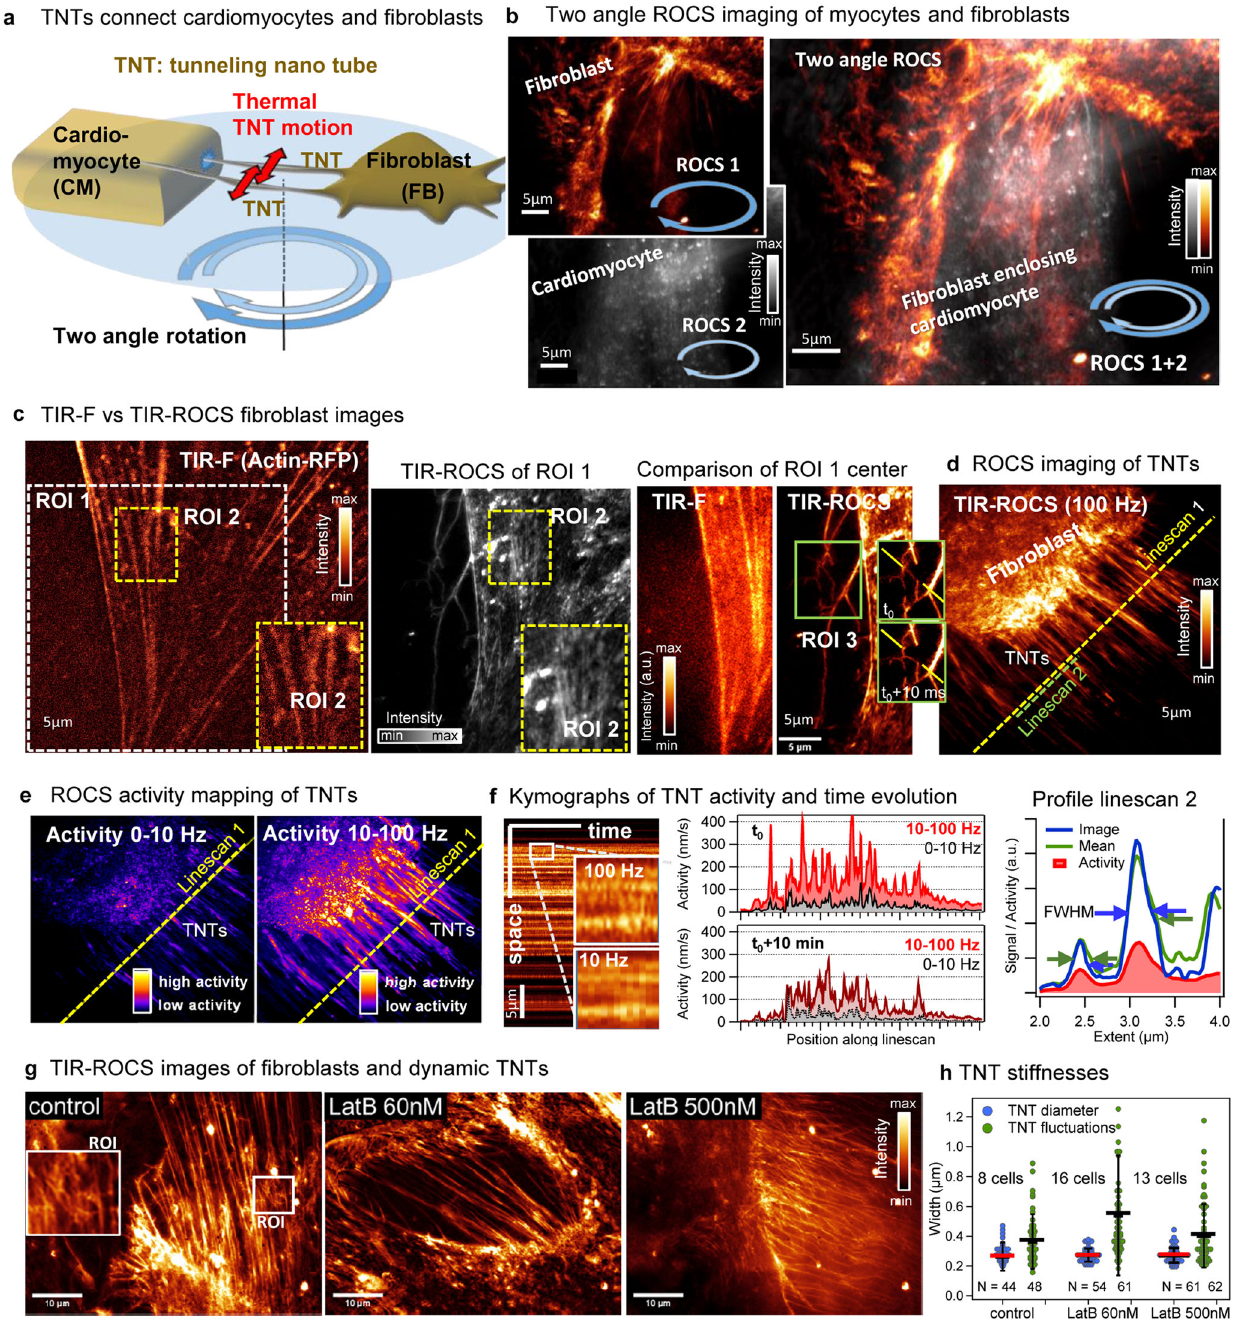
Fig. 5 ROCS microscopy of cardiomyocytes and fi broblasts. a Sketch of proposed cardiomyocyte (CM) – fi broblast (FB) interaction through tunneling nanotubes (TNTs) observed by two different polar illumination angles. Red arrows indicate lateral thermal motion of TNTs encoding the TNT stiffness. b The FB is imaged with TIR-ROCS, while the CM is imaged with ROCS in non-TIR mode. Image overlay shows enclosure of the CM by FB TNTs. c Imaging fi broblasts with TIR-F (actin-RFP) and with TIR-ROCS at 405 nm reveals actin stress fi bers with and without fl uorescence. TNTs emerging from FB are well visible with TIR-ROCS, but not with TIR-F. d TIR-ROCS imaging of FB with many TNTs, linescan 1 (yellow) and linescan 2 (green). e FB TNT activity mapped from 100 Hz ROCS movie over 10 s both on slow scale ( Δω = 0 – 10 Hz) and fast scale ( Δω = 10 – 100 Hz) revealing much higher activity on time scales (10 – 100 ms). f TNT dynamics analyzed along linescan 1. Kymographs over 1 s show TNT position changes at 100 Hz and at 10 Hz sampling. Activity pro fi les σ ( x ,100 Hz, t σ ( x ,10 Hz, t 0 ) in red and 0 ) in gray along linescan 1 (yellow dashed line) at time t 0 . 10 min later, thermal motion and activity are reduced. Intensity and activity line pro fi les with FWHM along the Linescan 2. g TIR-ROCS images of FBs cultured without and with Latrunculin B (LatB, 24 h). ROI shows cross-connections between TNTs. h Exemplary TNT diameters and fl uctuation widths σ from 8 – 16 cells and N = 44 – 62 TNTs. Horizontal red/black lines indicate the average diameters/ fl uctuations widths. Source data are provided as a Source Data fi